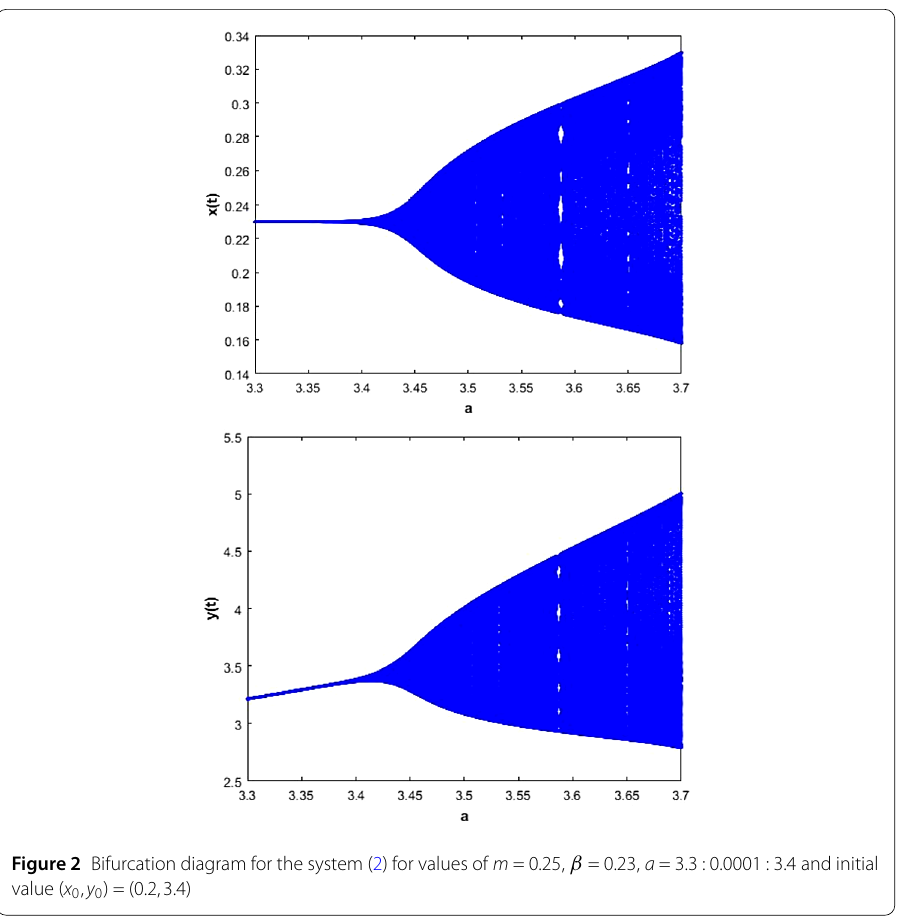
Figure 2 Bifurcation diagram for the system (2) for values of m = 0.25, β = 0.23, a = 3.3 : 0.0001 : 3.4 and initial value ( x